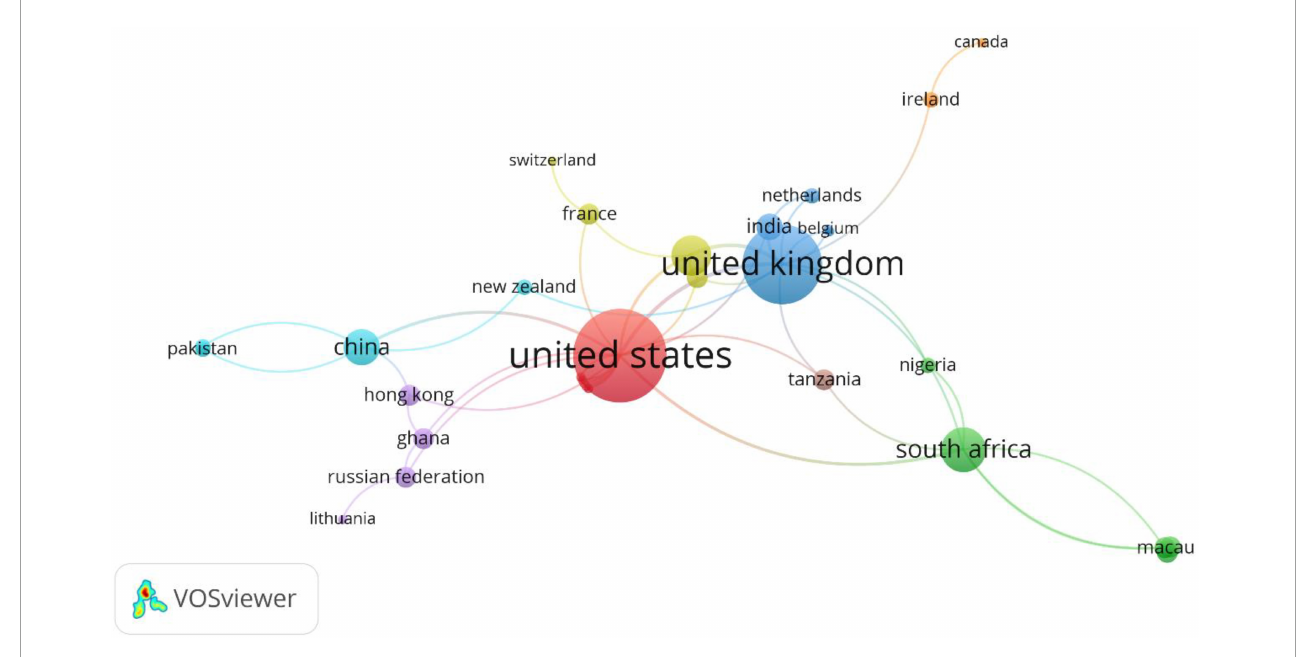
FIGURE3 Co-occurrence network of the most contributive countries.